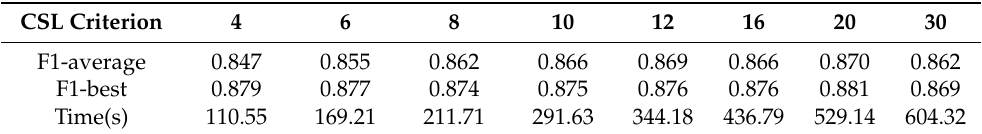
Table 4. Performance of prediction model under different CSL.